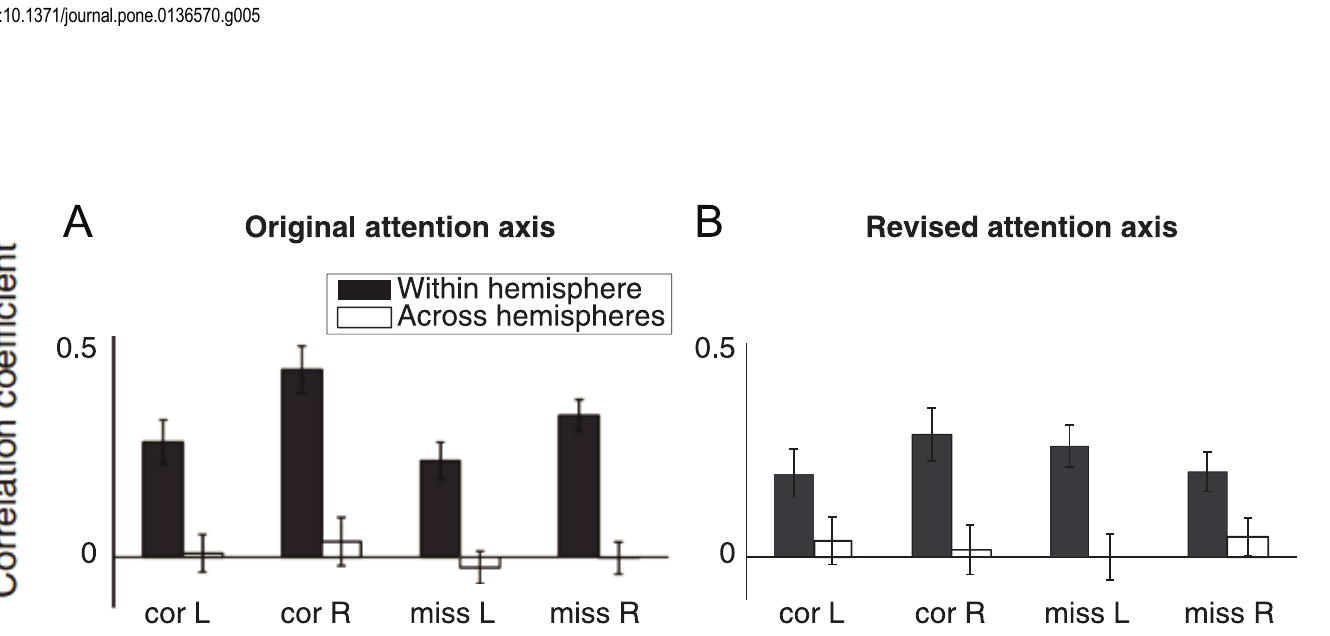
Fig 6. Attention axis positions are correlated when the axis is constructed using neurons recorded from the same hemisphere, but uncorrelated for those across left (L) and right (R) hemispheres. (A) , original attention axis, Fig 6 from [5]. (B) , revised attention axis.